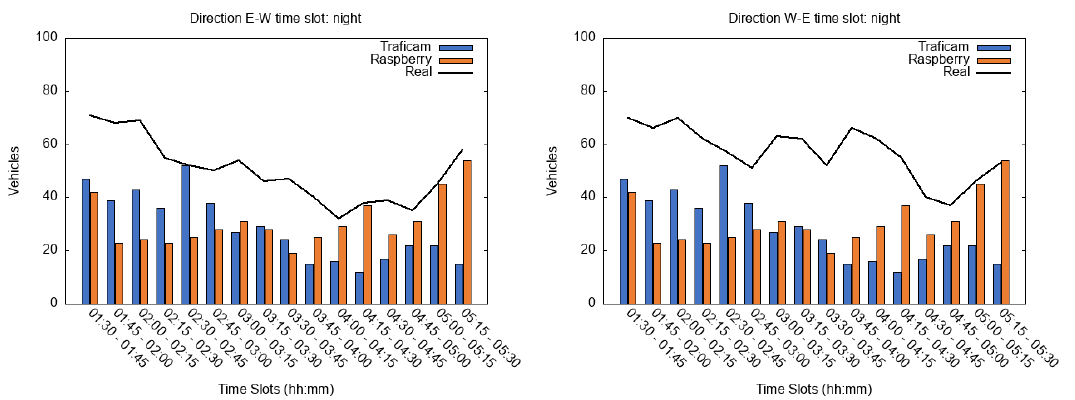
Figure 6. Comparison of Traficam (in blue) and Edge device (in orange) for vehicle counting during the night time slot. On the left part of the figure the direction E-W is shown, on the right part the direction W-E is displayed.